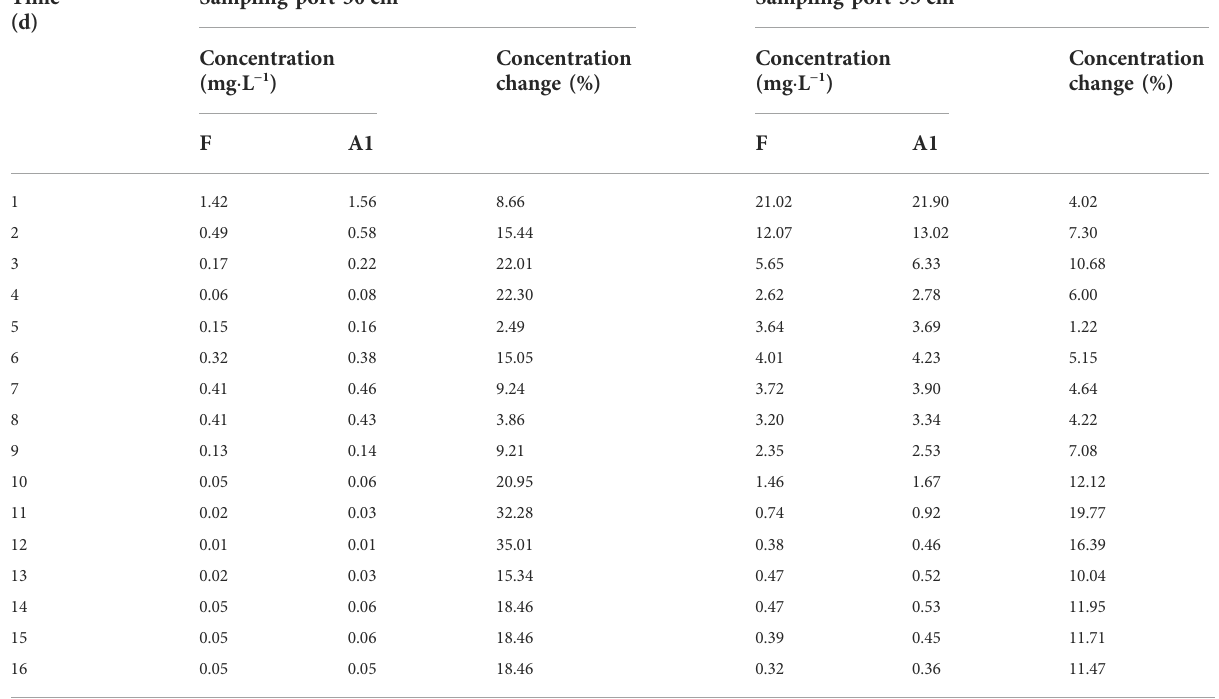
TABLE 6 Scenario 1: comparison of Pb concentration in the sampling water of the medium sand column.